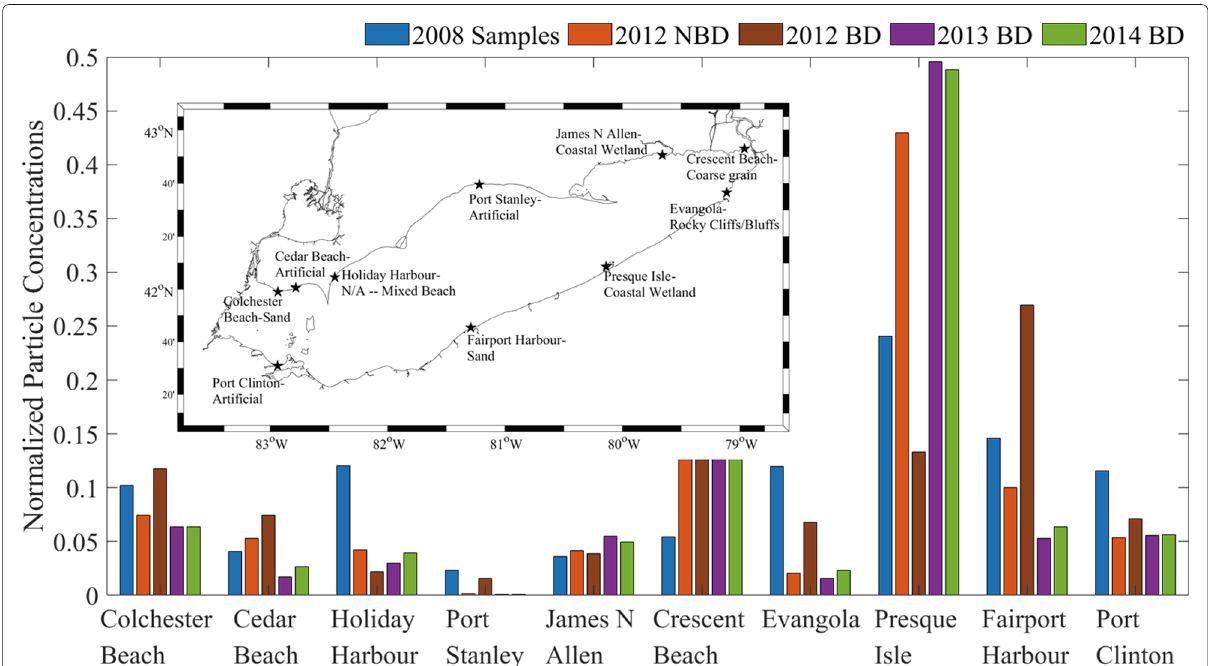
Fig. 8 Comparison to 2008 samples [13] for 2012 with no beach type dependence (NBD) and 2012-2014 with beach type dependence (BD). Model classifications of beach type and sample locations shown on the inlaid